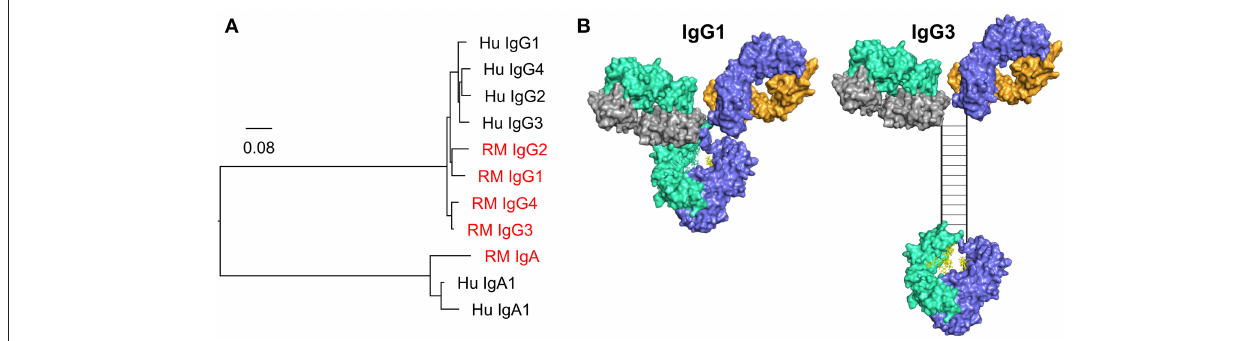
FIGURE 4 | (A) Phylogenic tree of human (Hu) and rhesus macaque (RM, red) IgG and IgA C H genes. Scale bar represents the percentage sequence dissimilarity as a measure of phylogenetic distance. (B) The human IgG3 hinge region is elongated when compared to IgG1. The hinge region in the hybrid surface/schematic rendering of human IgG3 is drawn to scale, with an estimated hinge length of 80 angstroms, as estimated by Lu and colleagues using small angle x-ray scattering data, and consistent with prior estimates from electron microscopy data (185, 186). Disulfide bonds ( n = 11) are represented by rungs in the ladder structure